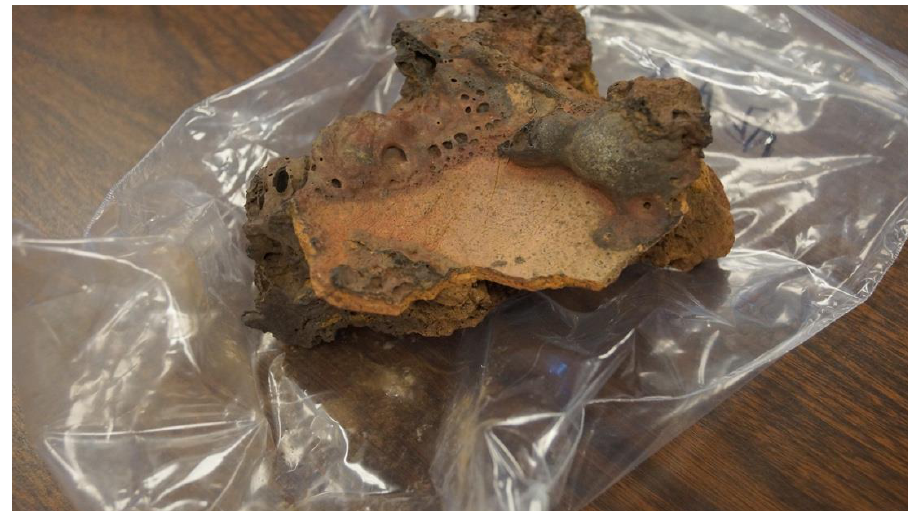
Figure 18. Sherd Rock found at Little Springs.